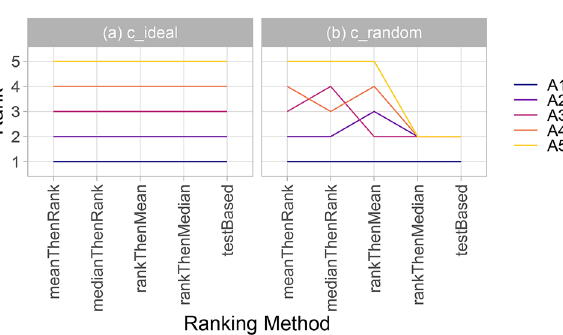
Figure 4. Line plots for visualizing the robustness of ranking across different ranking methods. Each algorithm is represented by one colored line. For each ranking method encoded on the x-axis, the height of the line represents the corresponding rank. Horizontal lines indicate identical ranks for all